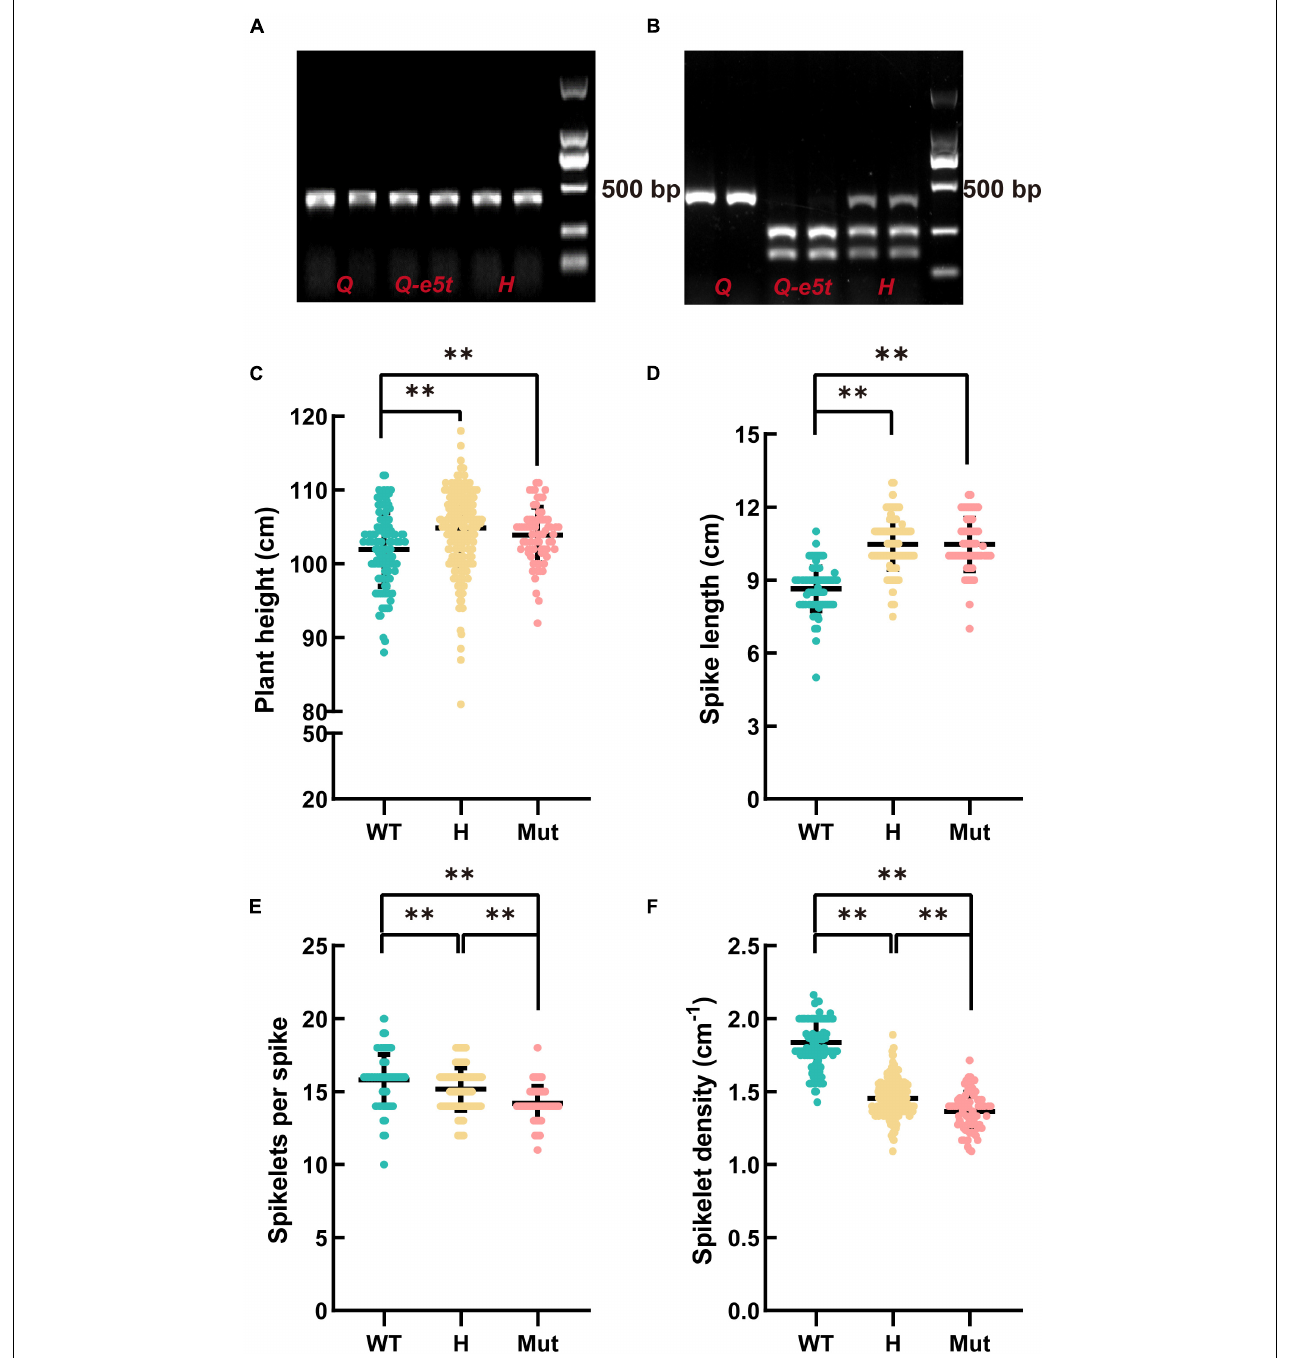
FIGURE 4 | Development of the diagnostic marker Q-CAPS-3 and the phenotypic characteristics of the F 2 population. (A) The PCR product of Q-CAPS-3. (B) The cleavage product of the Dde I restriction enzyme. H indicate the heterozygous genotype. (C–F) The plant heights, spike lengths, numbers of fertile spikelets per spike and spikelet densities of different genotypes. WT, Mut and H indicate the Q allele, Q-e5t allele and heterozygous genotype, respectively. ** indicates significant differences at the 0.01 level (Student’s t -test).